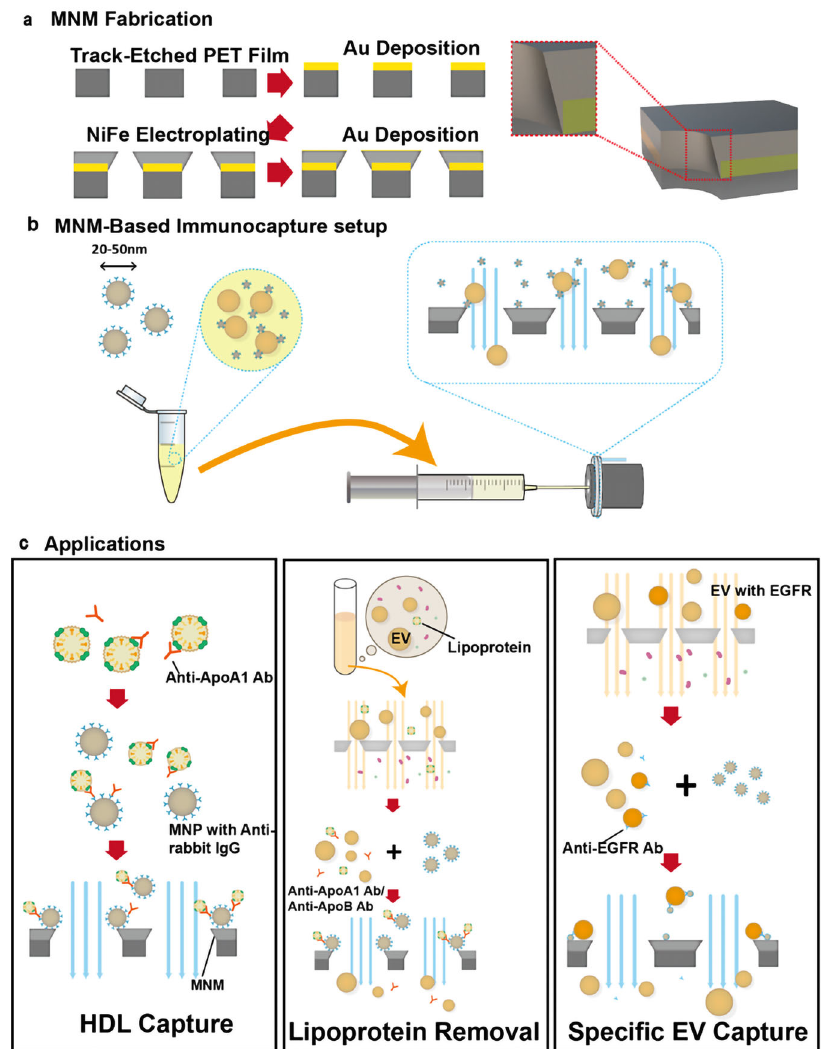
Fig. 1 Schematic of the experimental procedure. a Fabrication of the magnetic nanoporous membrane (MNM). In all, 80 nm Au was deposited onto the tracked-etched PET fi lm to provide good adhesion and electric conductivity for electroplating. Then 200 nm NiFe fi lm was deposited onto the membrane with electroplating. In all, 10 nm Au was deposited fi nally to reduce non-speci fi c adsorption and chemical instability. On the right: The heterogeneous nanoedge junction at the edge of the nanopore on the membrane is highlighted. b MNM-based immunocapture setup. First, the antibody and antigen were incubated to form an Ab – Ag complex, followed by incubating with magnetic nanobeads, which were conjugated with anti-rabbit IgG antibodies. Then the diluted sample was run through the chamber of the MNM device with a syringe and pump. The MNM device was assembled with the MNM sandwiched between two 3D-printed chips. The device was assembled between two magnets, with the magnet near the inlet in a ring shape. The magnetic beads were captured onto the edge of the nanopores, as highlighted. c Experimental steps of the three applications. Anti-ApoA1 antibodies were used to capture HDL; an Asymmetric nanopore membrane was used to isolate the EVs, with a small amount of HDL remaining, and we used MNM to remove the residual HDL to purify the EV fraction; In the EV fraction, MNM was utilized to capture the speci fi c EV with particular surface protein, i.e.,